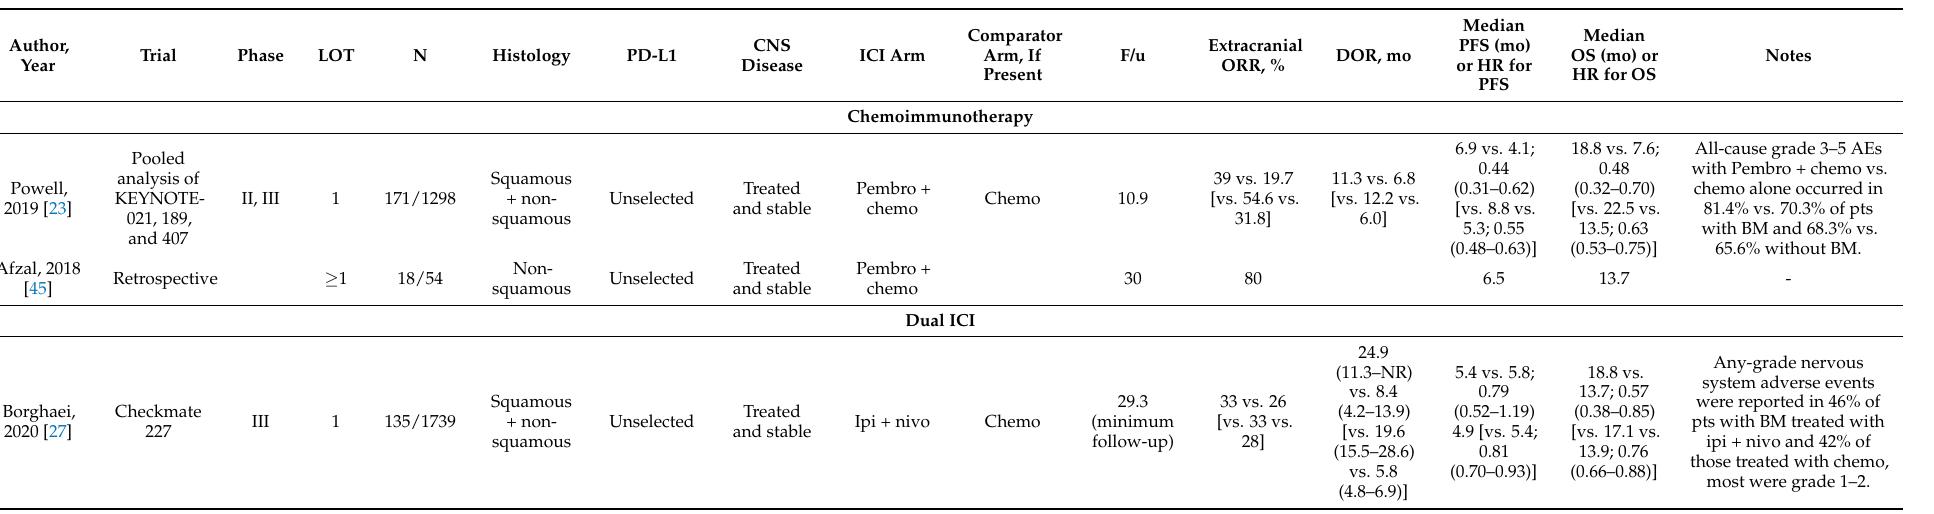
Table 3. Summary of clinical studies with immune checkpoint inhibitor combinations in patients with brain